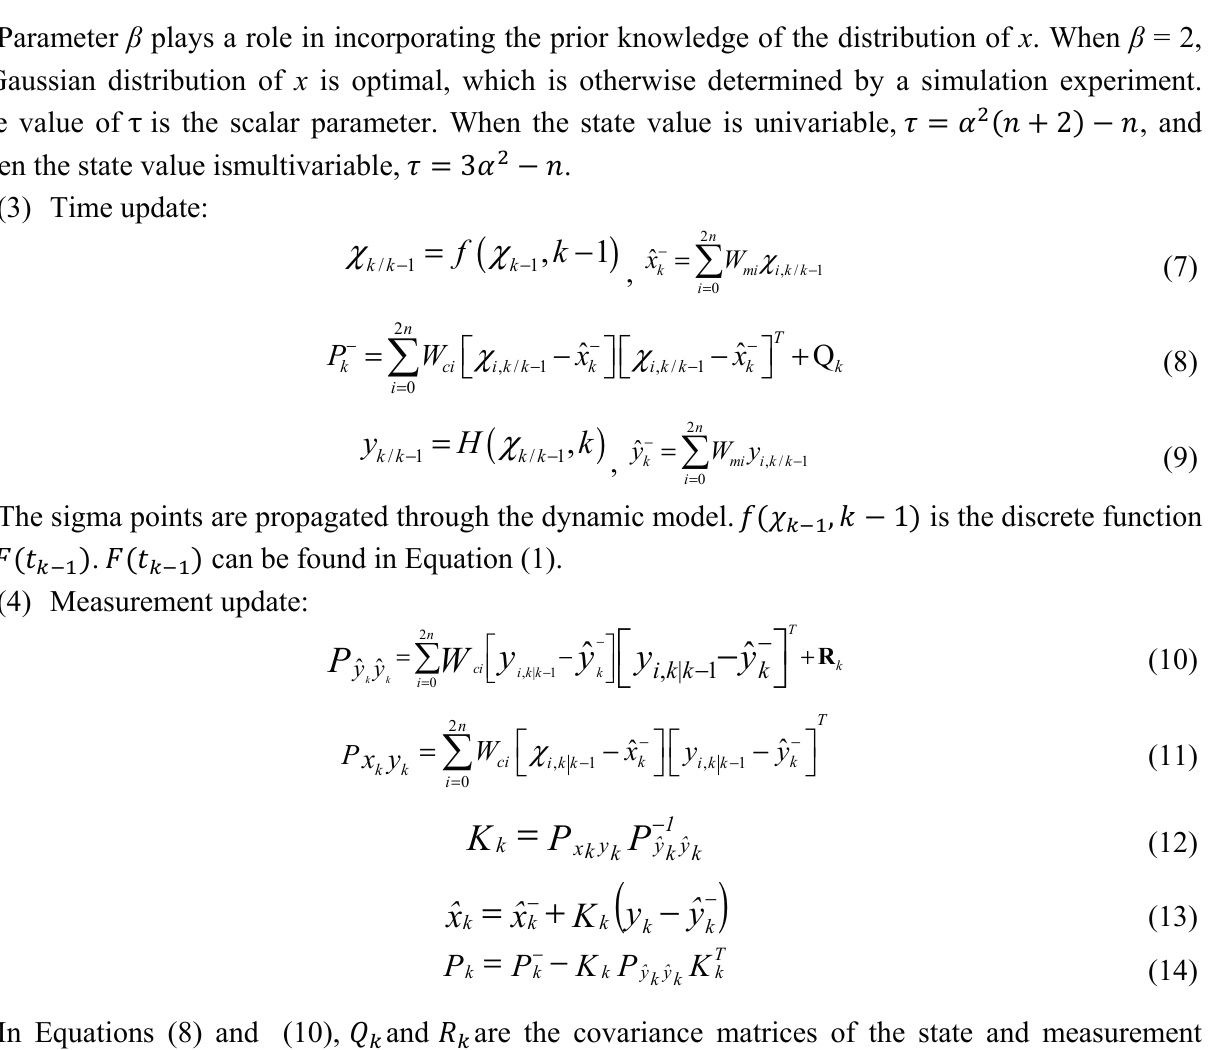
Figure 2. Unscented Kalman